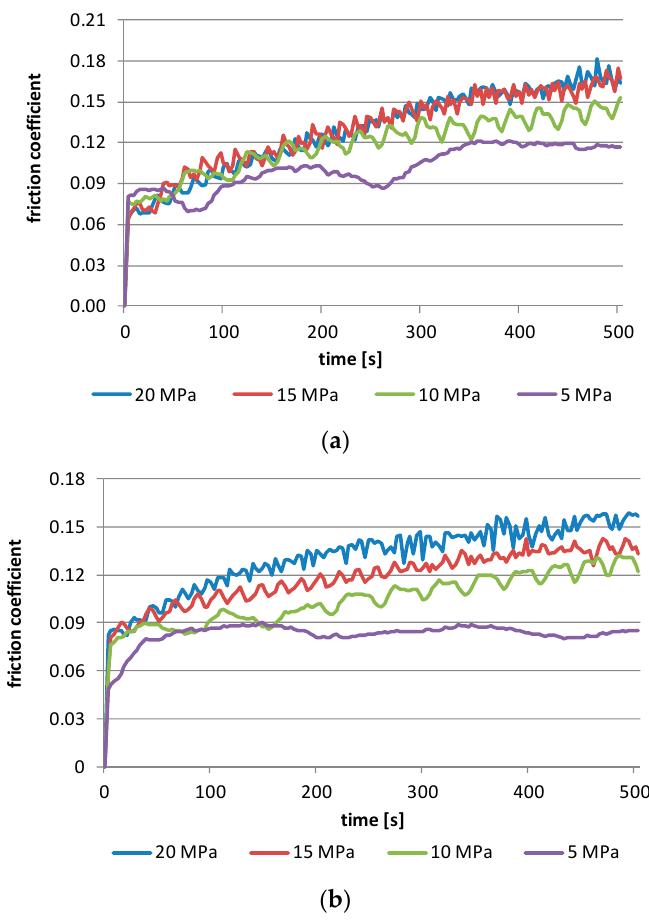
Figure 5. Friction coefficient in a sliding couple with laser borided surface layer vs rotation speed, lubricated with ( a ) 15W-40 mineral engine oil, ( b ) 5W-40 synthetic engine oil.